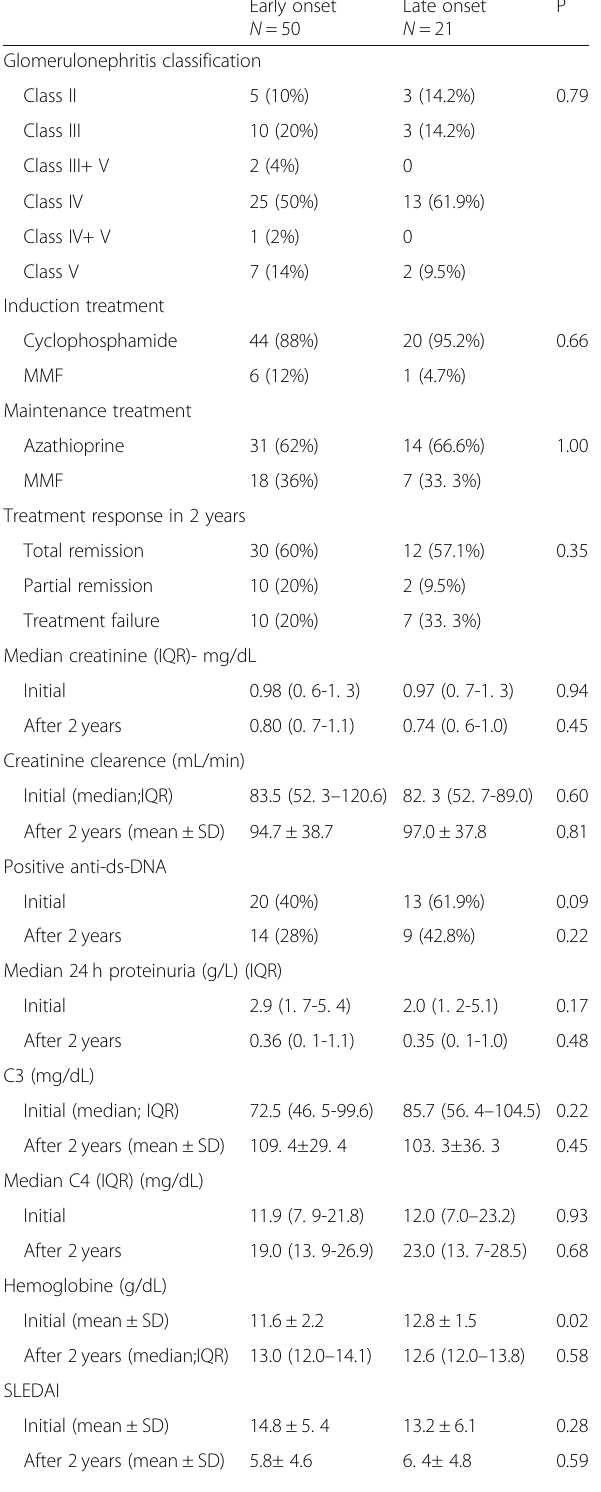
Table 2 Comparative analysis of main characteristics and treatment response in Systemic Lupus Erythematosus (SLE) patients with early and late onset nephritis